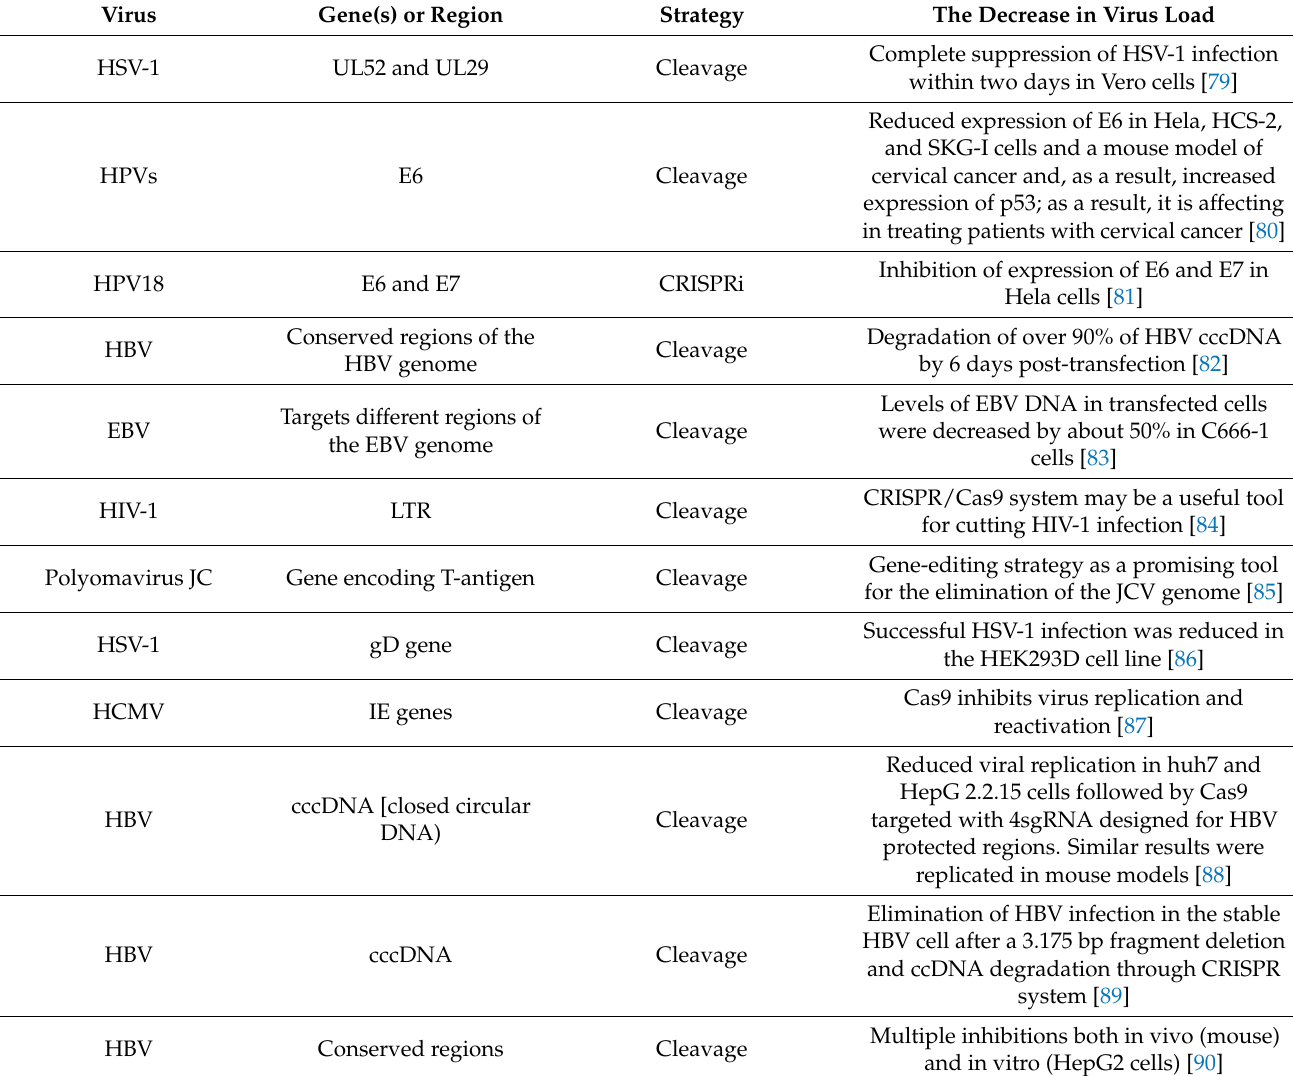
Table 3. Examples of viral load reduction by using the CRISPR